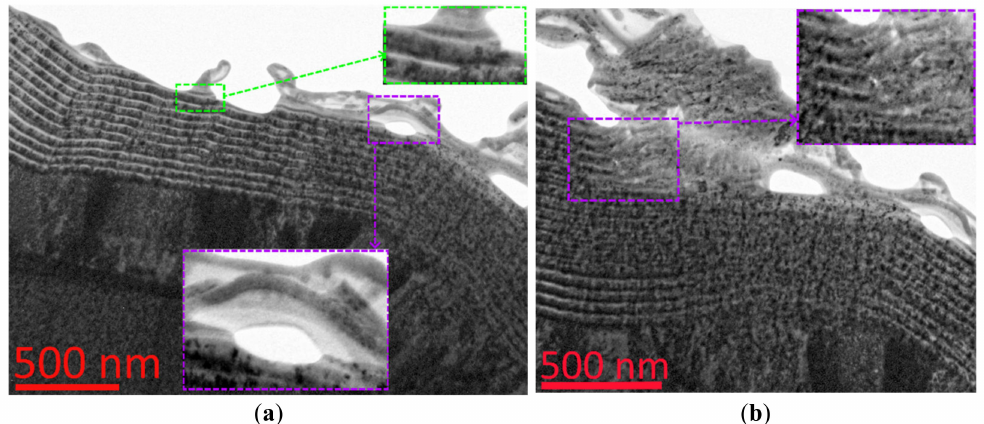
Figure 9. ( a , b ) Wear pattern on the (Zr,Mo,Al)N coating during the turning of Inconel 718 at the cutting speed of v c = 200 m/min, after 12 min of cutting.